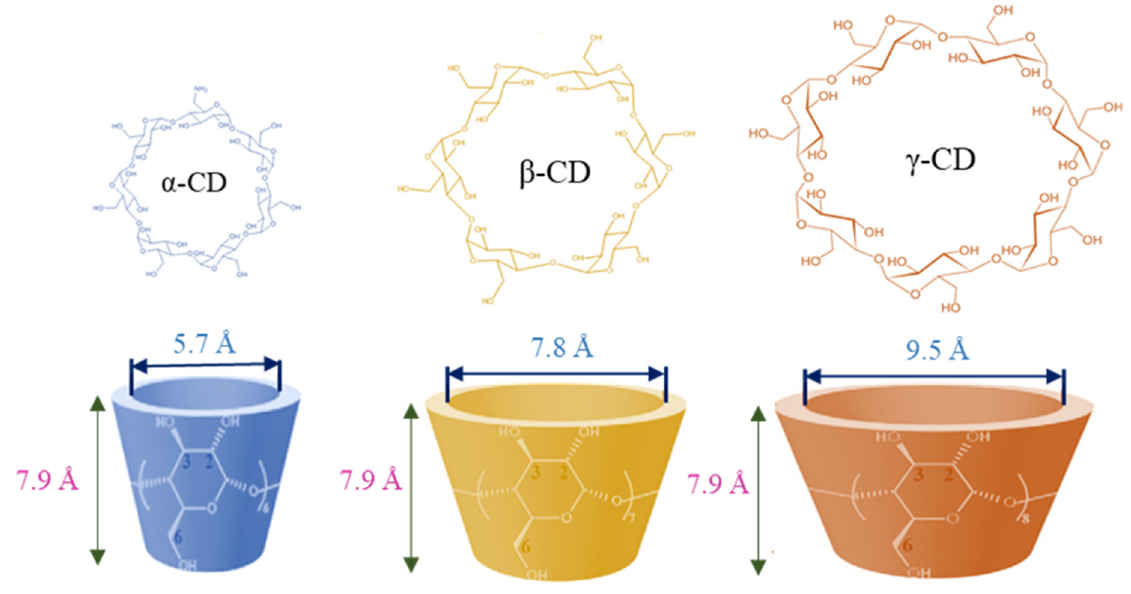
Figure 3. Molecular structure and dimensional characteristics of various cyclodextrins [71].